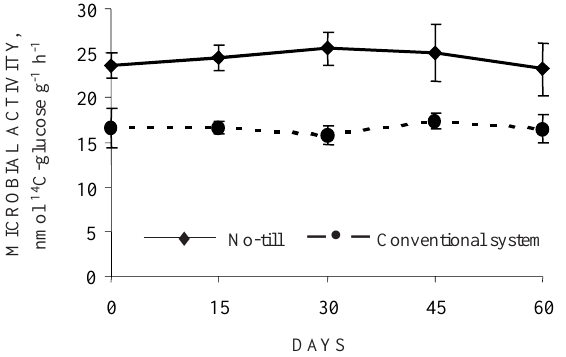
Figure 2. Microbial activity in a Brazilian Rhodic Oxisol under 23 years with no-till and conventional management soil systems. Bars represent standard